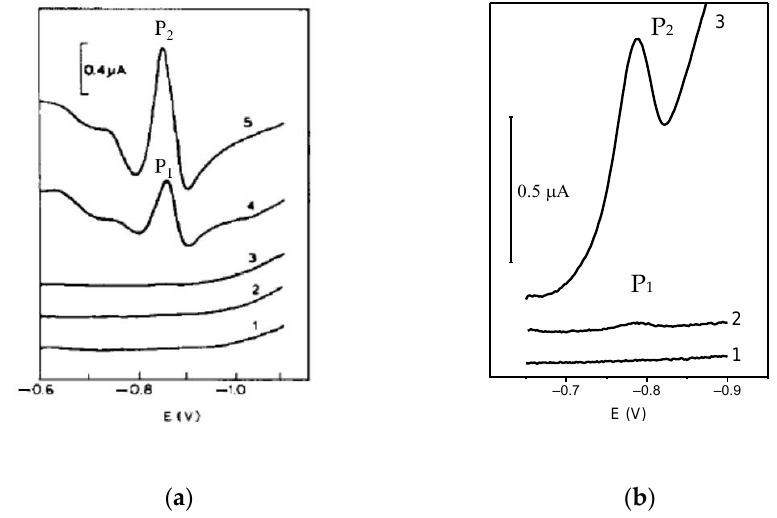
Figure 4. ( a ) Linear scan AdSV voltammograms recorded for: (1) 0.07 M acetate buffer (pH 4.6), (2) as in (l) + 0.1 µM of Ge(IV), (3) as in (l) + 1.5 mM catechol, (4) as in (3) + 0.1 µM Ge(IV), (5) as in (4) + 0.1 M NaBrO 3 , working electrode: DME. Reprinted with permission from ref. [35]; ( b ) DP AdSV voltammograms recorded for: (1) 0.09 M of acetate buffer and 20 nM of Ge, (2) as (l) + 2 mM of catechol, (3) as (2) + 0.014 M of KBrO 3 ; working electrode: HMDE; instrumental parameters E acc = - 0.2 V, t acc = 80 s. Adapted with permission from ref. [40].